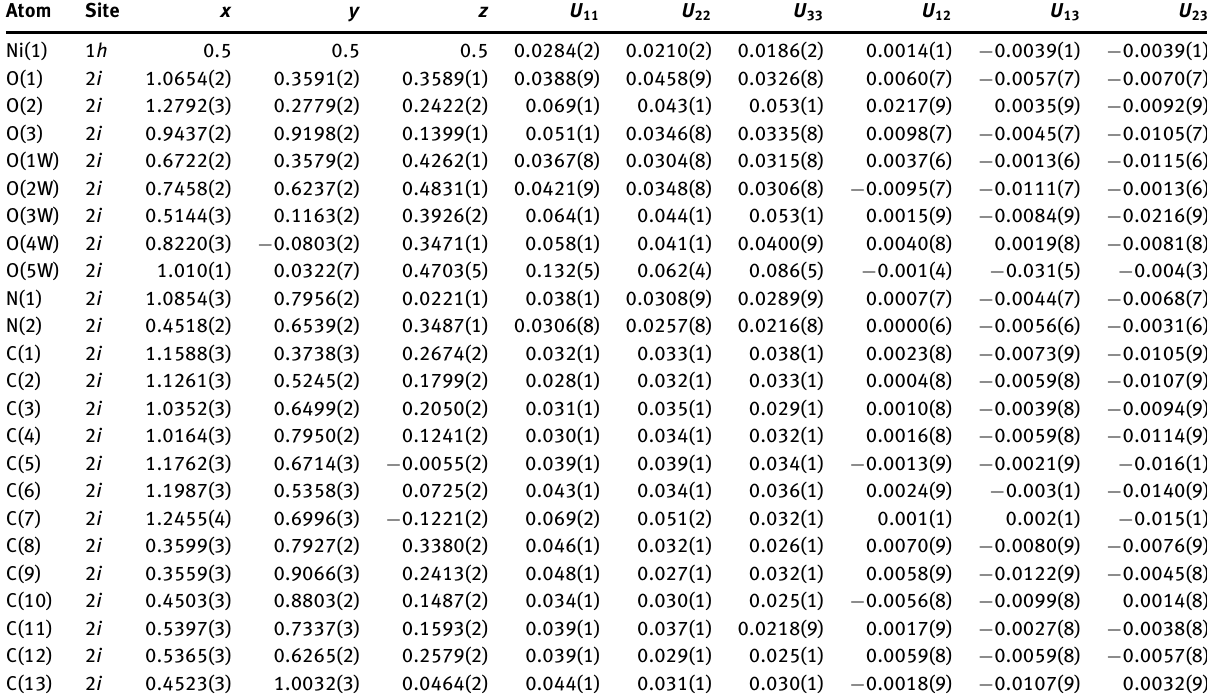
Table 3: Fractional coordinates and atomic displacement parameters (Å 2